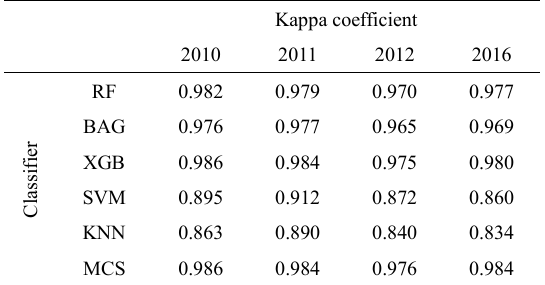
Table 2. Kappa coefficient for five individual classifiers and MCS